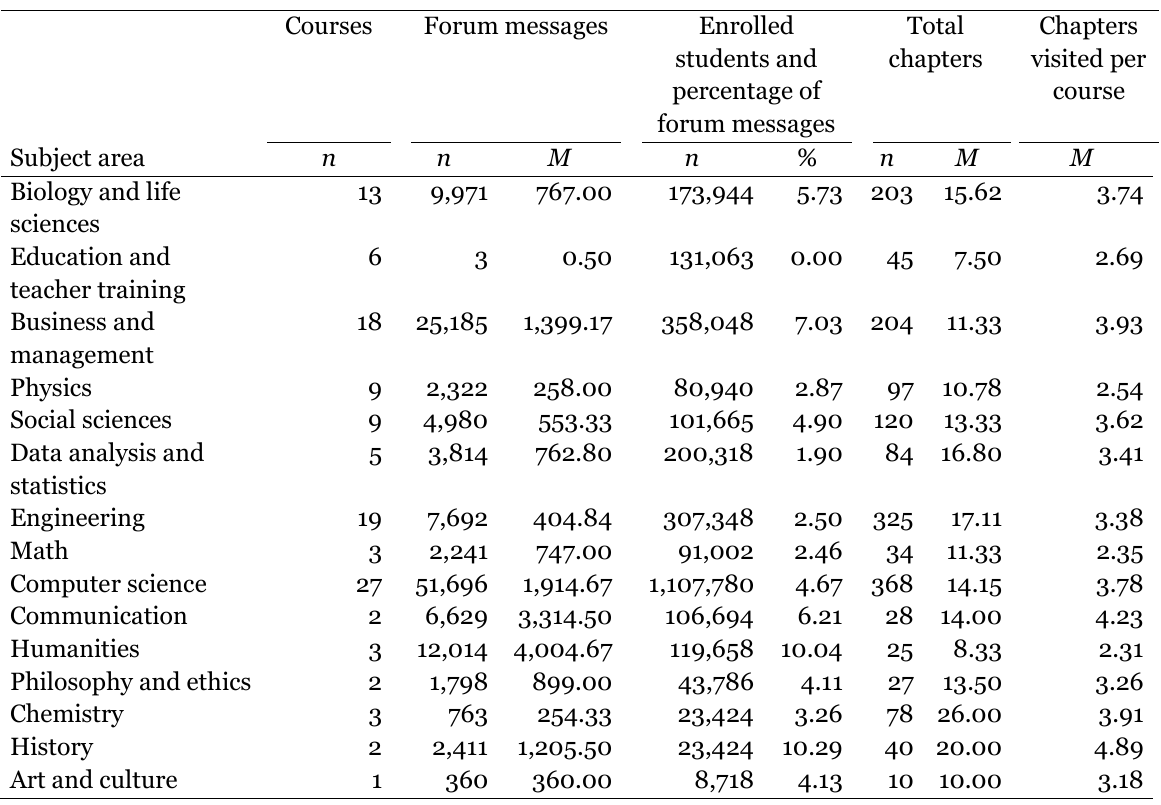
Learner Activity According to Subject